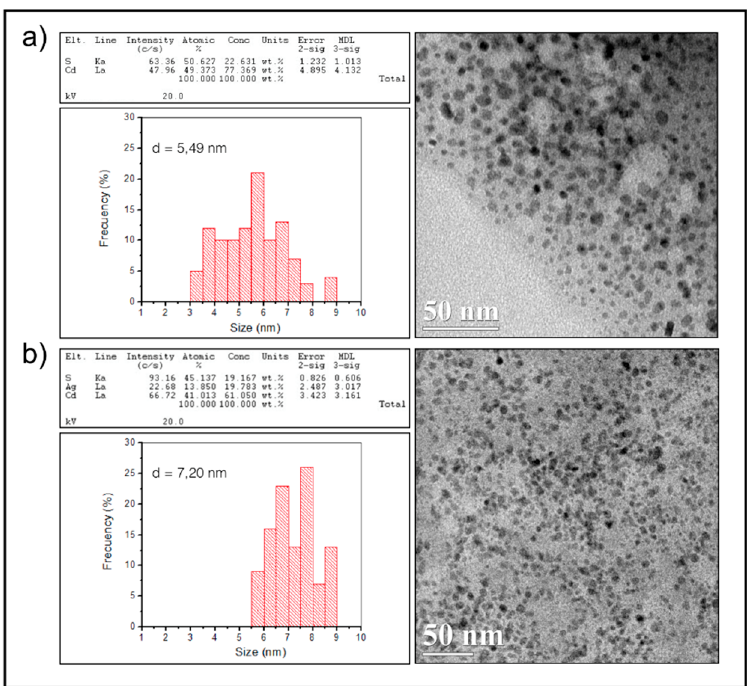
Figure 4. EDS, HR-TEM, and frequency histograms of biosynthesized CdS ( a ) and CdSAg ( b )